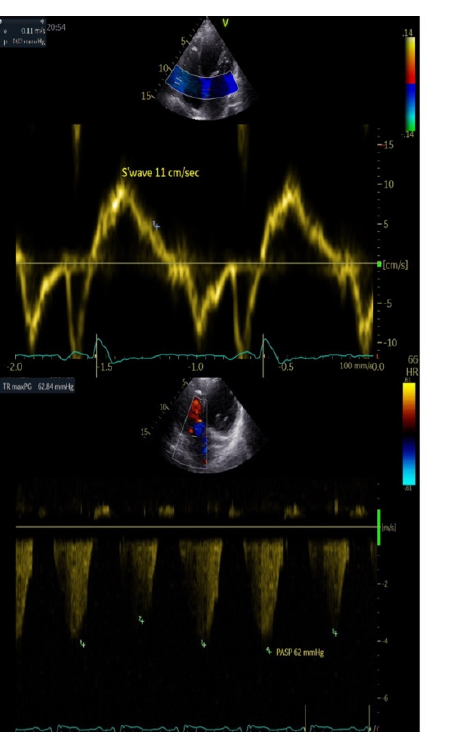
RVOT prox.: right ventricular outflow tract proximal diameter; RVOT dist.: right ventricular outflow tract distal diameter; RVD 1: right ventricular basal dimension; RVD 2: right ventricular mid-cavity dimension; RVD 3: right ventricular longitudinal dimension; TAPSE: tricuspid annular plane excursion; S wave: peak systolic of the free wall of the right ventricle; PASP: pulmonary artery systolic pressure; PAMP: pulmonary artery mean pressure; PCWP: pulmonary capillary wedge pressure.